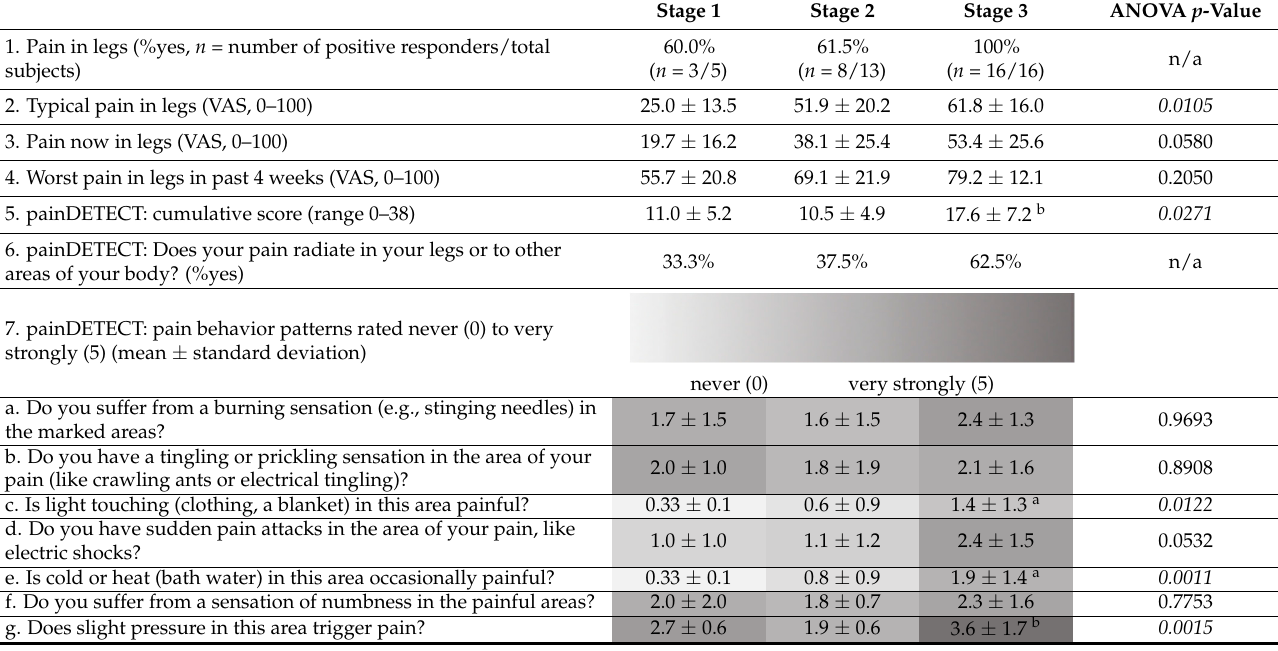
Table 2. Summarized pain questionnaire responses questions. Questions 1–4 are regarding leg pain by VAS response, while 5–7 are taken from the painDETECT survey questions regarding nociceptive pain descriptions. All controls responded “no” to Question 1. All subsequent questions were only inquired of those who responded “yes” to Question